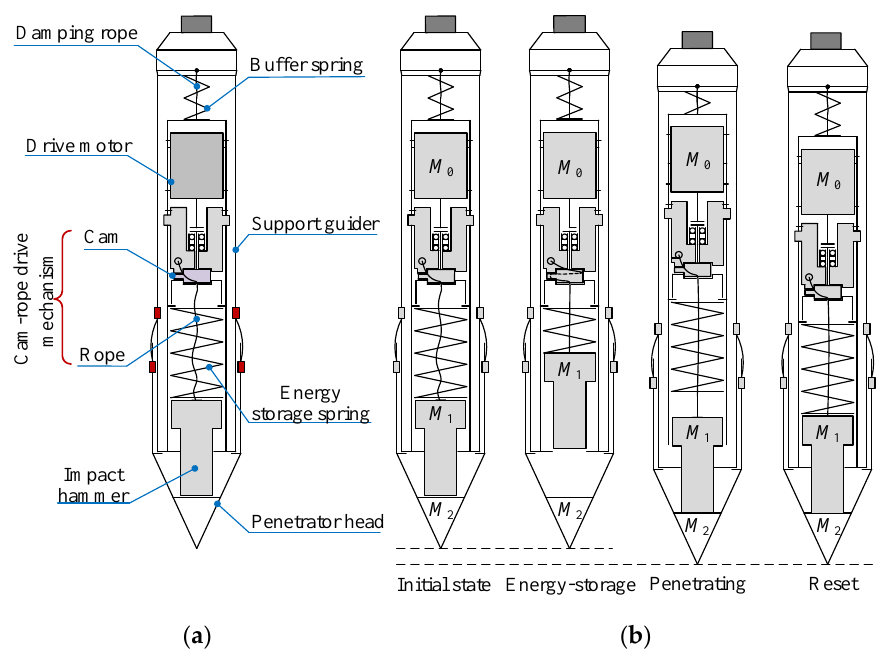
Figure 5. The structural components of cam-cable-driven mechanism energy-storing type penetrator and its working process: ( a ) structural components; ( b ) working process.